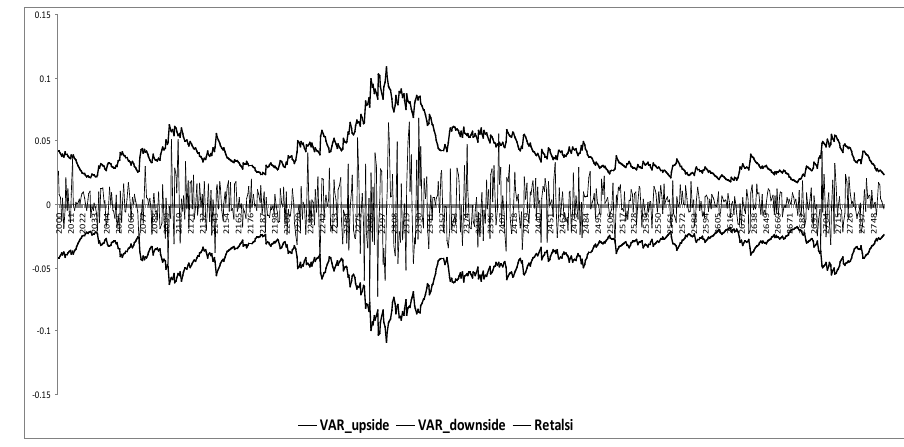
FIGURE 6: Egarch-GPD Source: Authors’ calculations, based on JSE ALSI return